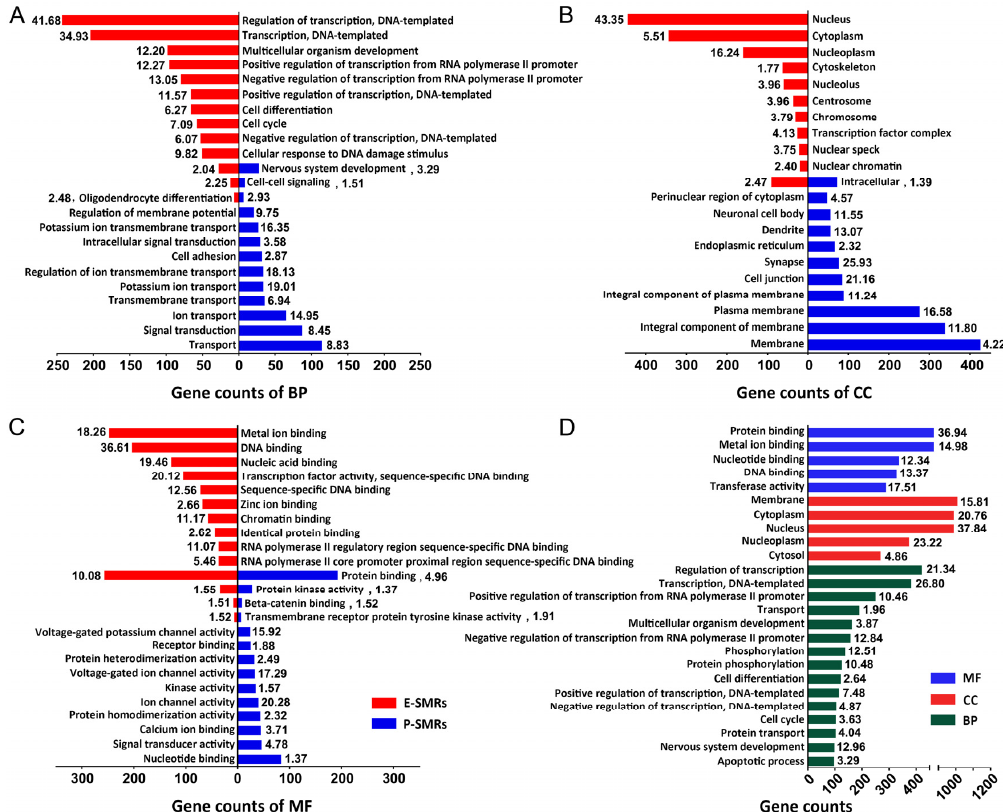
Figure 4. Functional association of m 6 A-methylation with transcribed RNAs. ( A – C ) Gene ontology (GO) analysis on E-SMRs and P-SMRs in categories of biological process (BP), cellular component (CC) and molecular function (MF). ( D ) GO analysis on continuously methylated RNAs (CMRs). The– log10( p -Value) of each category is shown by the respective